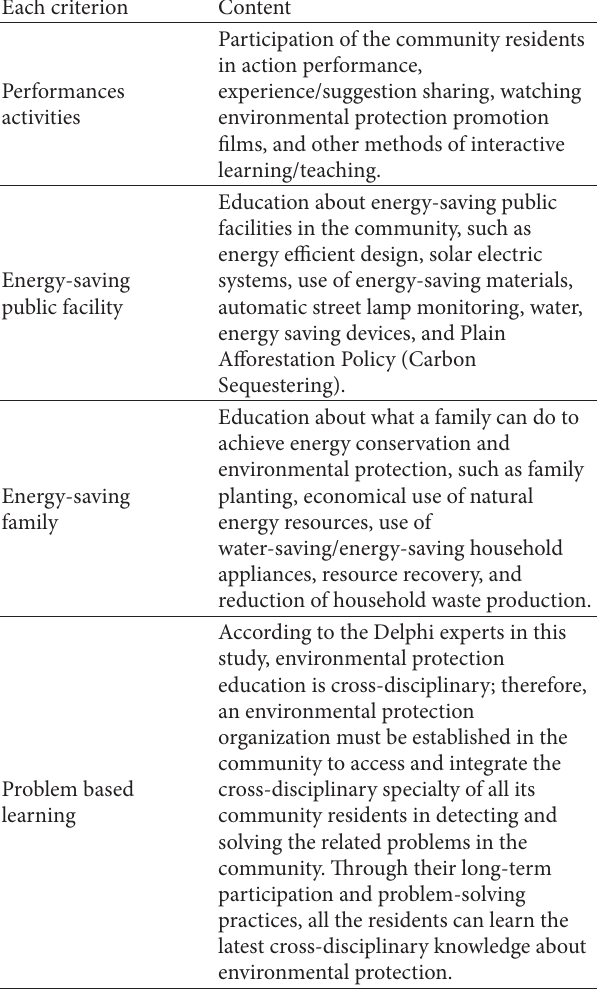
Table 1: Criteria jointly agreed by experts.